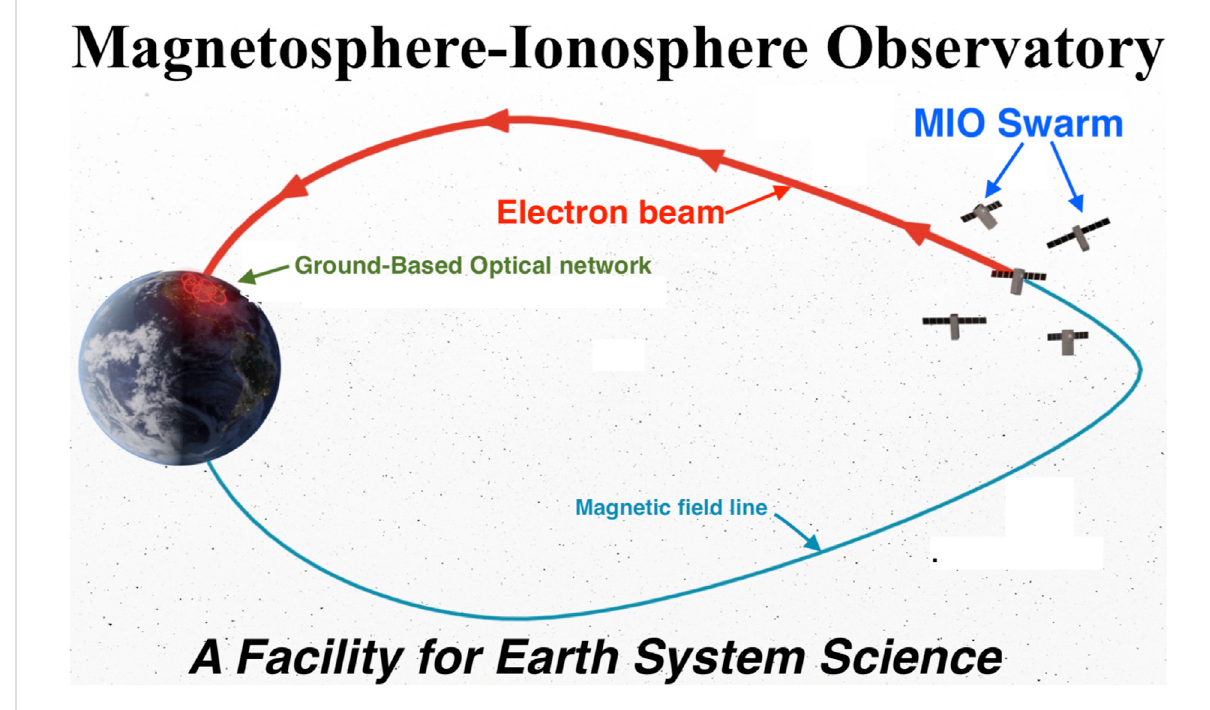
FIGURE 1 A depiction oftheMIO mission con fi guration, which includes amain spacecraft operating arelativistic-electron accelerator, 4nearbydaughter spacecraft making gradient measurements, and a ground-based optical network covering Canada and